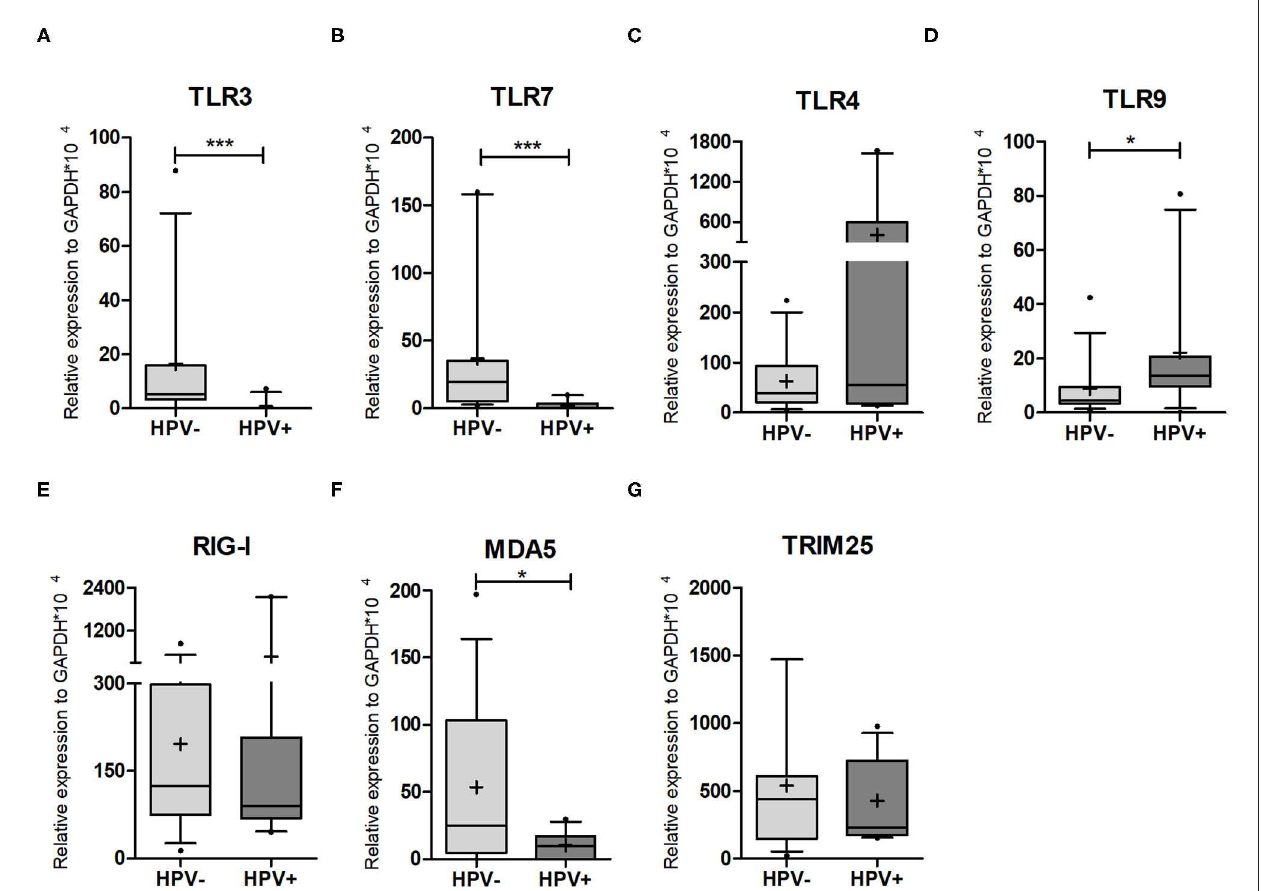
FIGURE 2 | PRR expression levels in cervical cells. qPCR on HPV- and HPV + cervical sample lysates was performed to assess the expression levels of (A) TLR3; (B) TRL7; (C) TLR4; (D) TRL9; (E) RIG-I/DDX58; (F) MDA5/IFIH1; (G) TRIM25. Relative expression of target genes was normalized to GAPDH (2 − 1 Ct ). Box plots represent 10–90 percentile; dots represent outlier samples; “ + ” represents the mean and the horizontal bar, the median. HPV- = 15 and HPV + = 11 women. Mann-Whitney U -test; * p ≤ 0.05; *** p ≤